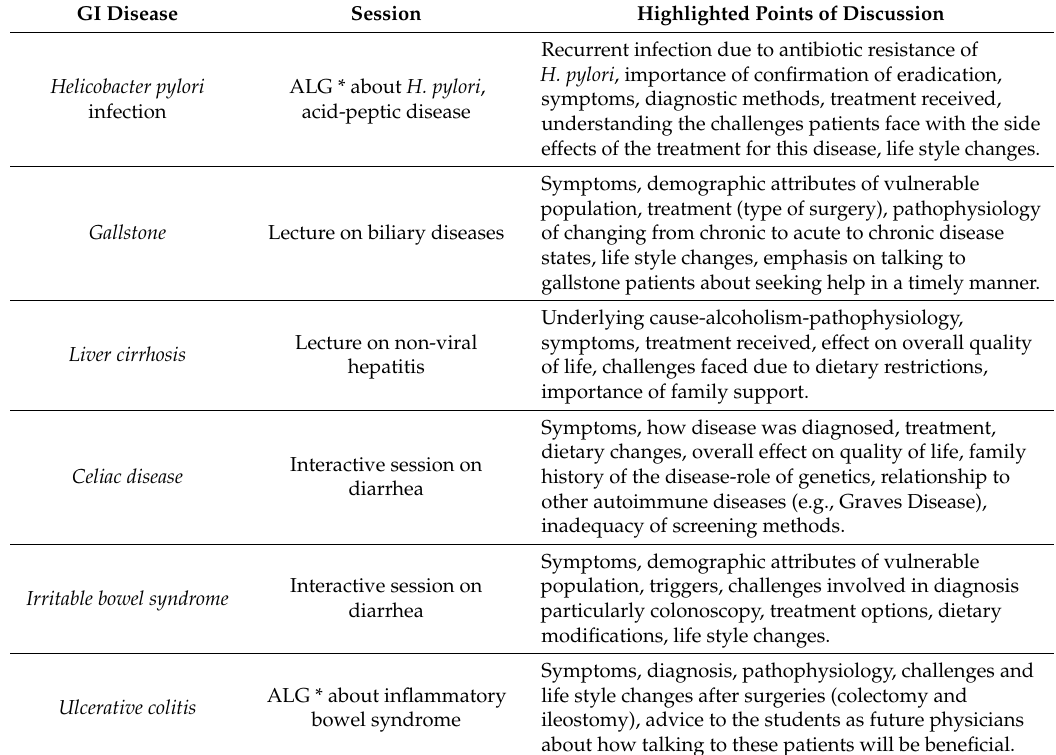
Table 1. Highlights of the patient